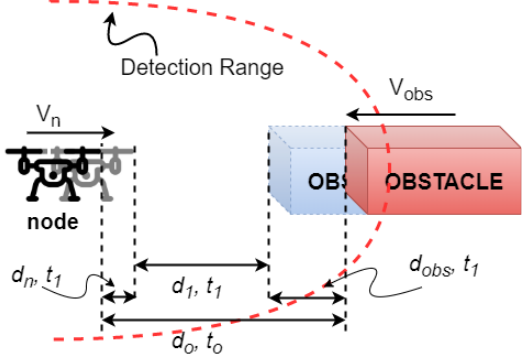
Figure 3. Illustration of calculation of movement of